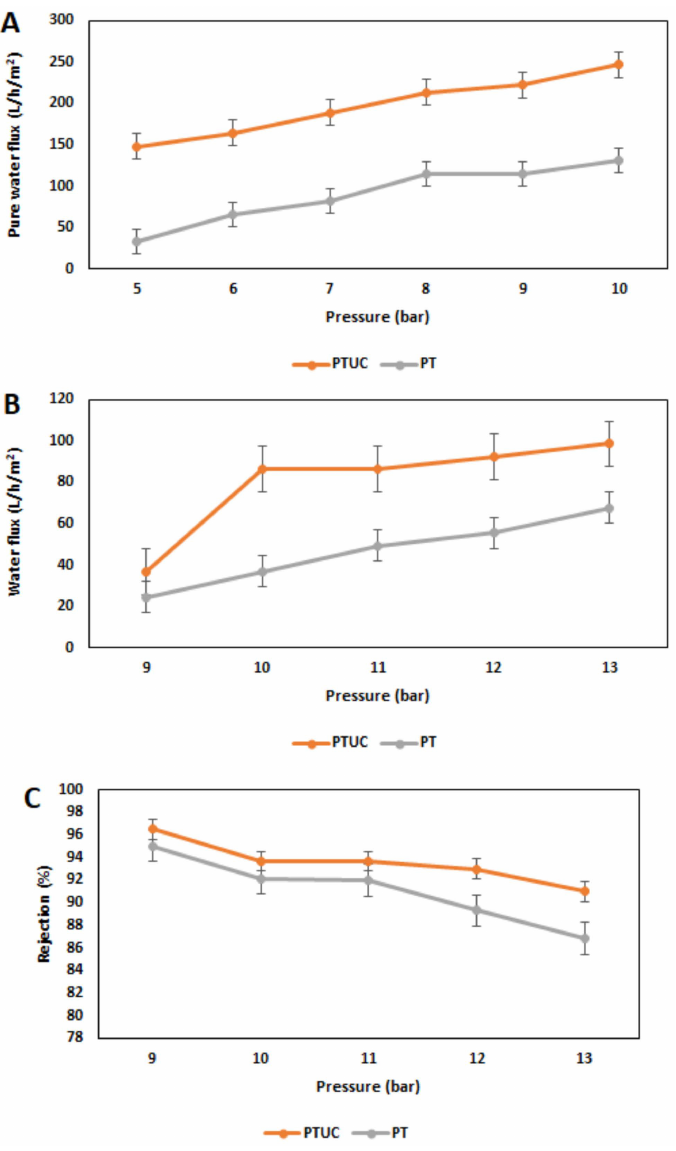
Figure 5. ( A ) Pure water flux. ( B ) Water flux for a solution containing 60 mg/L potassium nitrate. ( C ) Nitrate